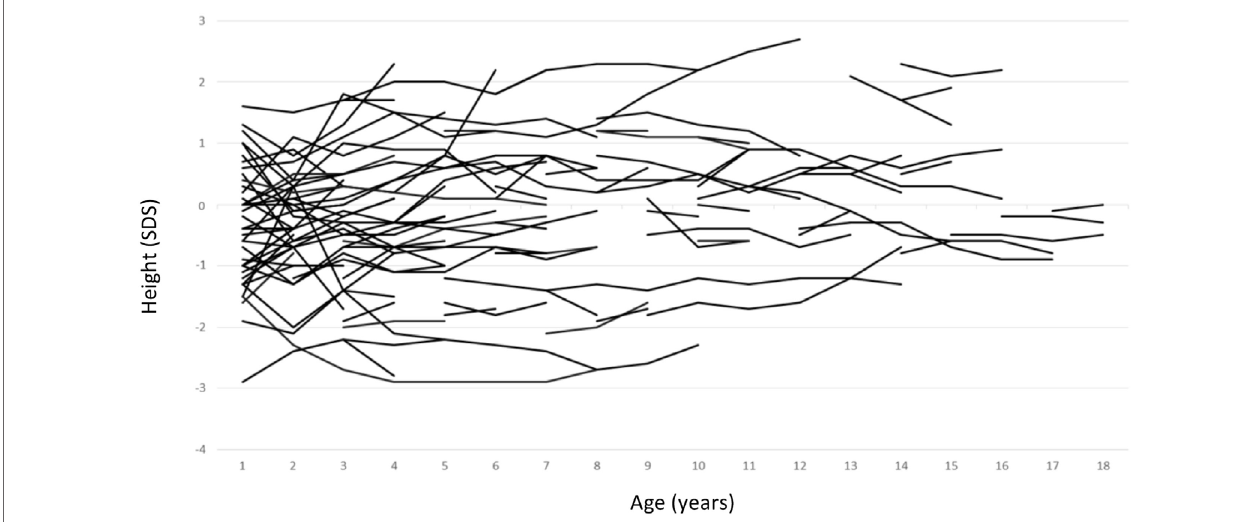
FigUre 3 | Individual childhood height standard deviation score curves of patients with long QT syndrome 1 due to loss-of-function mutations in KCNQ1